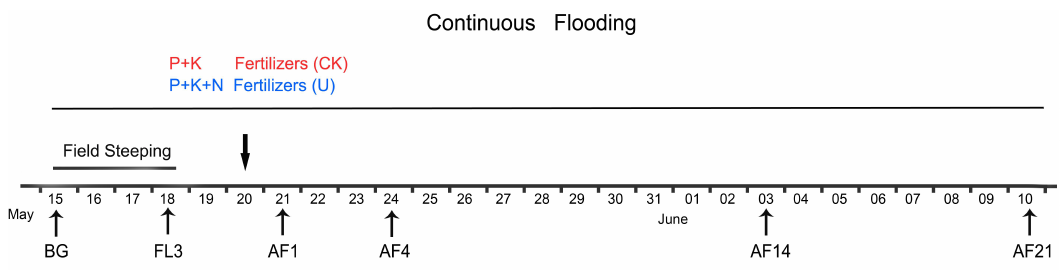
Figure 1. Detailed description of water management and fertilizer application in the experimental fields, and each sampling date. The downward facing arrow indicates that the application of fertilizers was performed on May 20th. Soil samples representing spring fallow period (FP) collection and starting irrigation were performed on the same day. Irrigation began immediately after FP samples collection. FL3, third day of flooding; AF1, 4, 14, 21 refer to the first, fourth, 14th, and 21st days after fertilization, respectively. Table 1. Physicochemical properties 1 of two treatments of